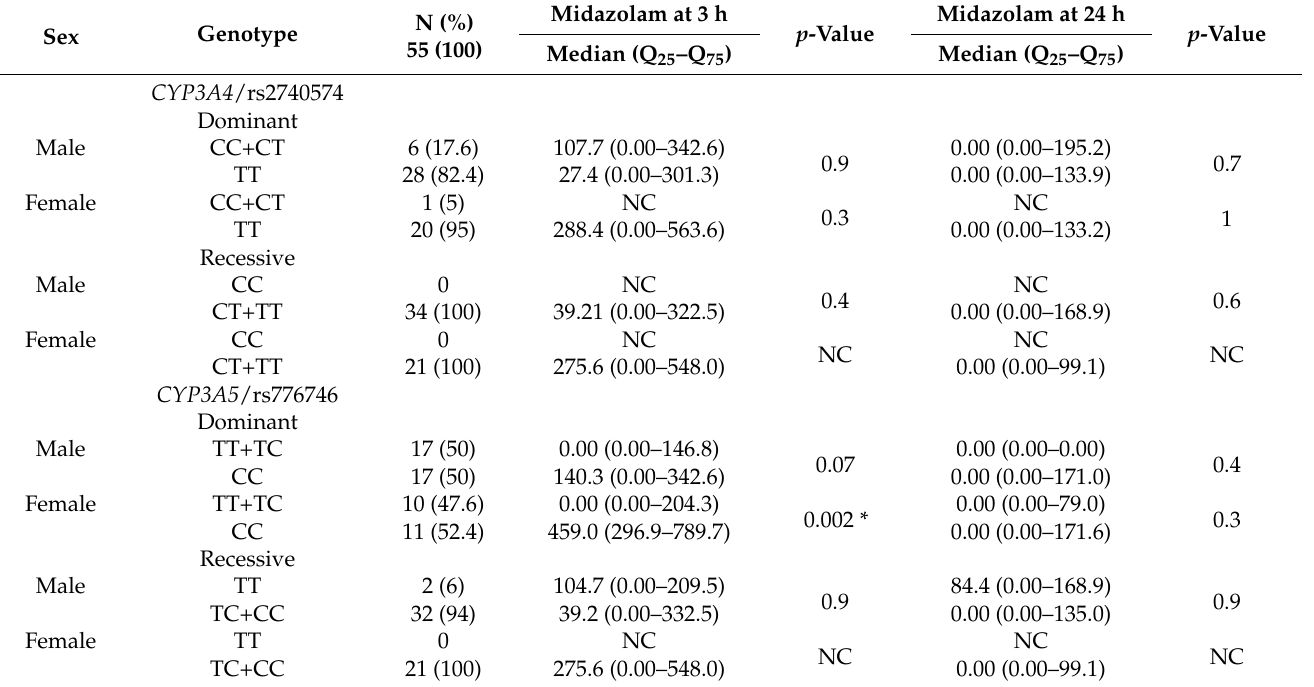
Table 3. Midazolam concentration according to the genotype and stratified by